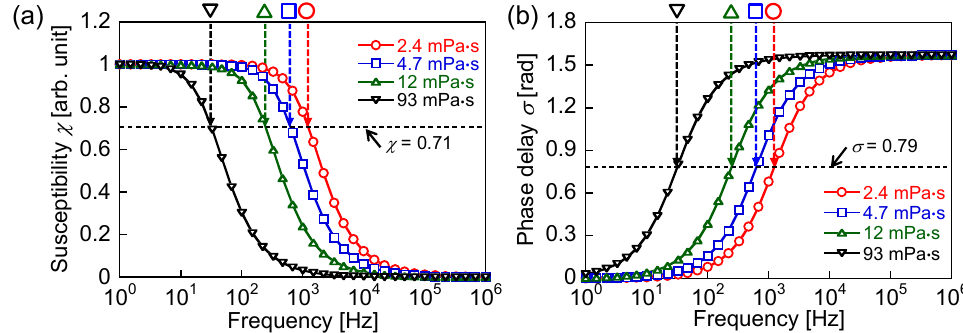
Figure 3. Theoretical ( a ) susceptibility and ( b ) phase delay of the magnetization, calculated by Equations (11) and (12), respectively, for viscosities of 2.4, 4.7, 12, and 93 mPa ∙ s. The dotted lines show the susceptibility and phase delay for the conditions indicated by Equation (4). When these conditions are satisfied at the frequencies of the relaxation peaks, χ and σ are 0.71 and 0.79, respectively. The intersections of the dotted lines and the curves indicate the theoretical frequencies of the Brownian relaxation peaks for each viscosity, which are listed in Table 1.